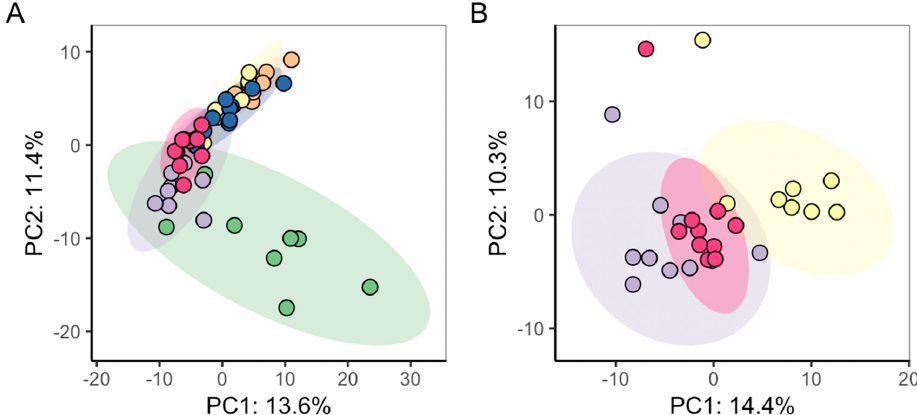
Figure 6. PCA scores plots (PC1 vs. PC2) visualising ( A ) the metabolic differences across three exposure studies (termed biological batches), with each batch comprising of control ( n = 10) and CB-exposed (n = 10) samples; ( B ) only the control samples from each batch. Sample groups are biological batch 1 Control (Purple) and CB (Green), batch 2 Control (Yellow) and CB (Orange), and batch 3 Control (Red) and CB (Blue).